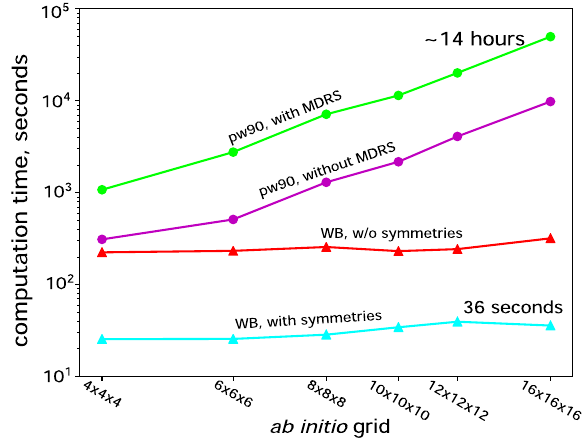
Fig. 3 Computational time for AHC. Time for calculations with WB (triangles) and postw90.x (circles) for different ab initio grids. For postw90.x, the calculations are done with (green) and without (purple) MDRS. For WB , the calculations are done with (cyan) and without (red) use of